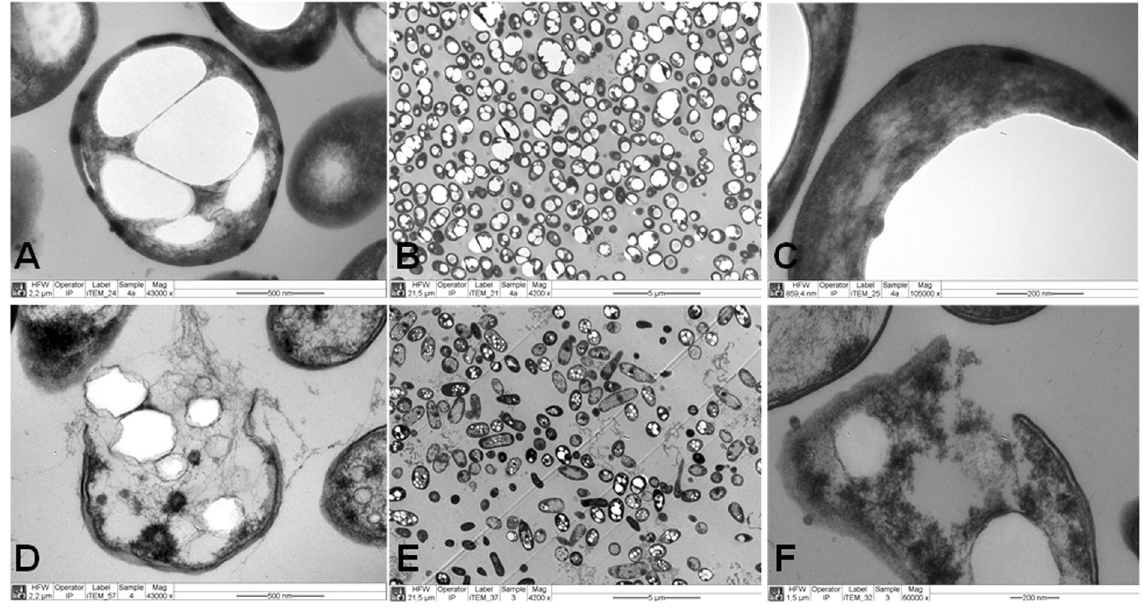
Figure 5. Transmission electron micrographs of P . putida KT2440 ( A , B , C ) and the engineered JBOi strain 24 h after induction ( D , E , F ). All images were taken 96 h after the start of the